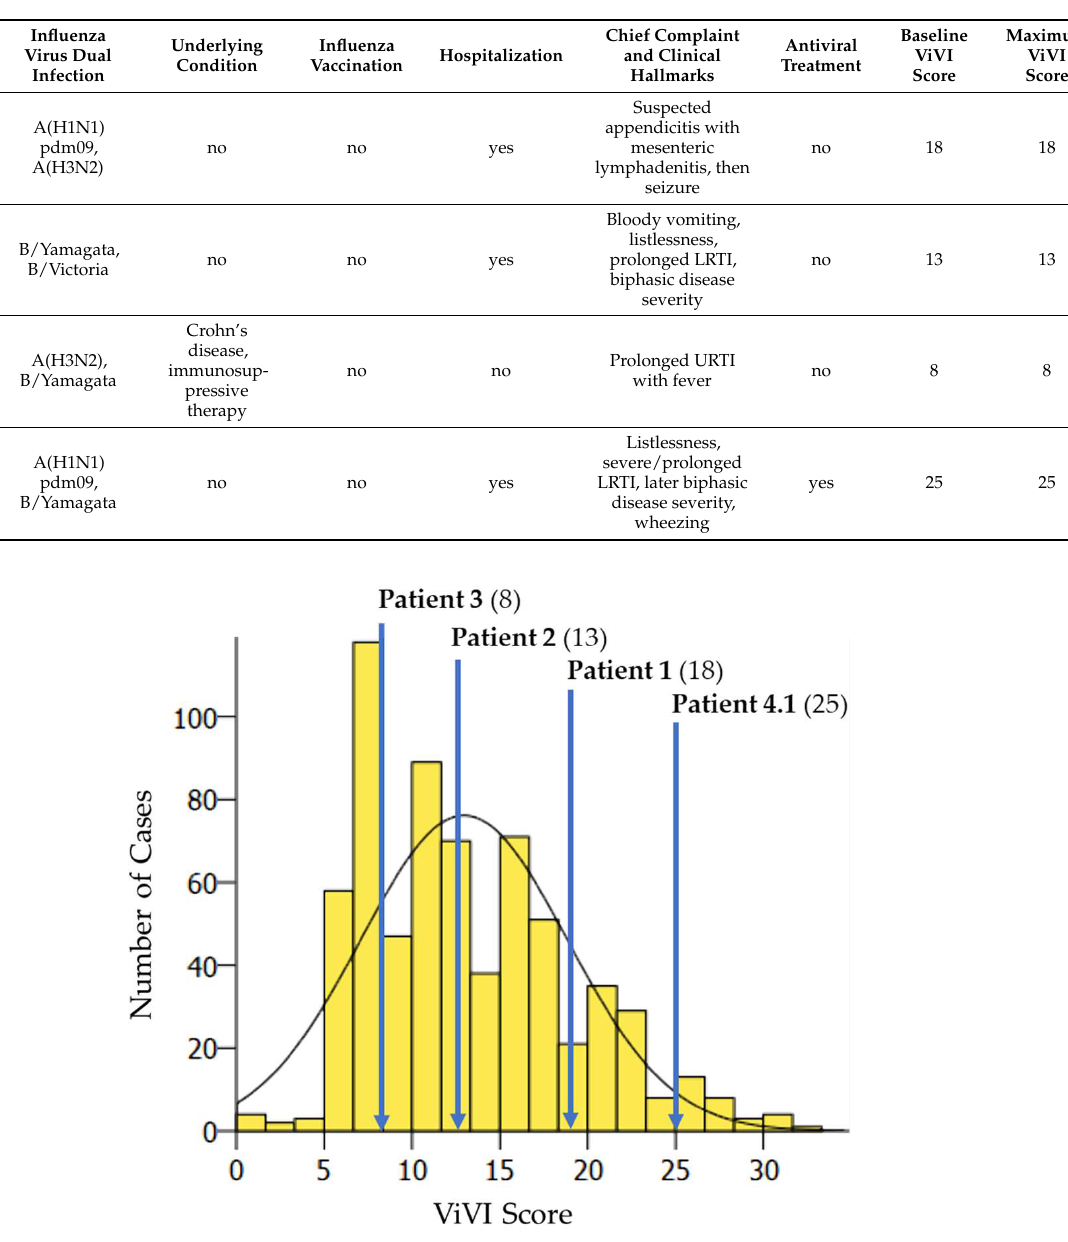
Table 1. Patient specifics of all four influenza virus dual infections. F—female, M—male, URTI— upper respiratory tract infection, LRTI—lower respiratory tract infection.